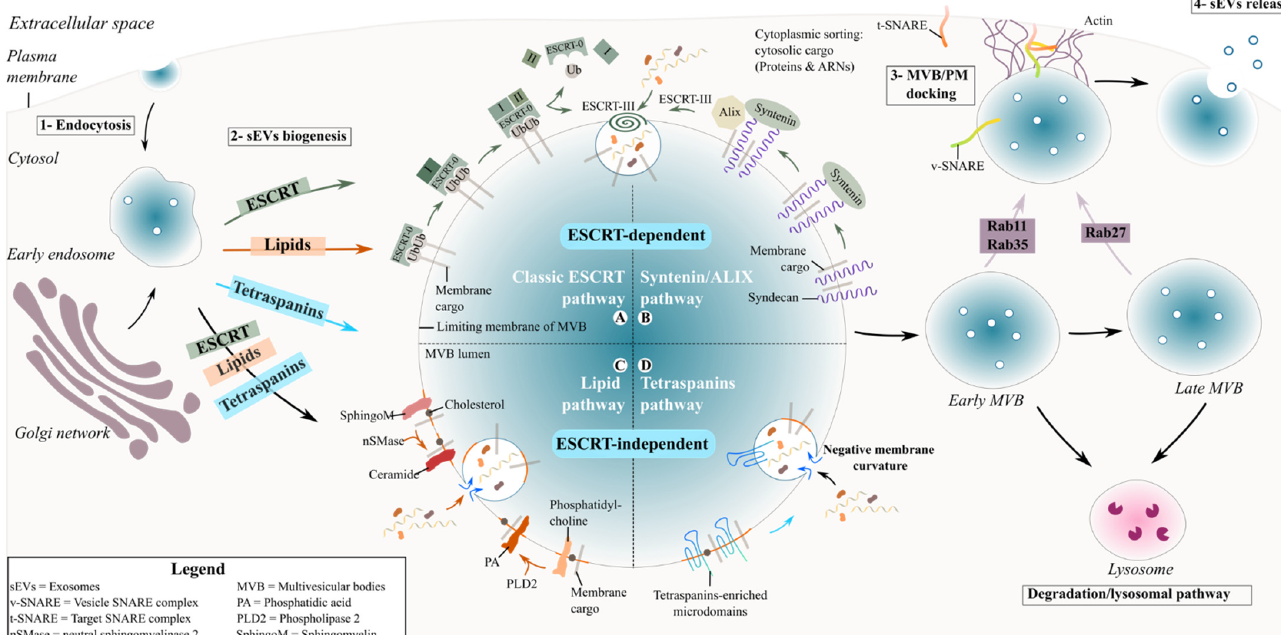
Figure 1. Biogenesis and secretion of exosomes. Schematic representation of exosome formation and release in the extracellular space. ( 1 ) Exosomes are produced as ILVs by inward budding of the endosomal membrane and accumulate in the lumen of the endosome. ( 2 ) Several mechanisms are involved in the biogenesis of exosomes such as ESCRT protein-, lipid- raft- and tetraspanin microdomain-dependent pathways. Whether one or multiple pathways are required simultaneously by one population of MVBs, or if each pathway is specific to one population of MVB, is still not clear. ESCRT-dependent pathways: ( A ) the most described mechanism involved in the biogenesis of exosomes is the ESCRT-dependent pathway requiring proteins of the ESCRT family. Specific transmembrane ubiquitinated cargo is recruited and clustered at the MVB membrane by the ESCRT-0 complex, subsequently binding to the ESCRT-I structure. The ESCRT-II complex is activated and together with ESCRT-I will create and/or stabilize the vesicle neck. Finally, ESCRT-III and its associated proteins will drive neck constriction. ( B ) The second ESCRT-dependent biogenesis pathway is the syntenin/ALIX pathway. The formation of syndecan-enriched microdomains leads to syndecan cleavage and the formation of syntenin/syndecan complexes that interact with ALIX. The syntenin–syndecan–ALIX complex then favours the recruitment of the ESCRT-III complex to support the MVB membrane curvature and abscission. ESCRT-independent pathways: ( C ) Ceramide- and phosphatidic acid-dependent pathways are based on the formation of lipid-rafts where sphingomyelin is converted to ceramide or phosphatidylcholine is converted to phosphatidic acid. The ceramide- and phosphatidic acid-enriched rafts induce the inward curvature of the MVB membrane. ( D ) Similarly, tetraspanin-enriched microdomains can induce a negative curvature in the MVB membrane. ( 3 ) MVBs will either fuse with lysosomes for degradation or with the plasma membrane, which will consequently release exosomes into the extracellular space ( 4 ). Several proteins have been identified in the transport and fusion of the MVB to the plasma membrane, such as proteins from the Rab protein family and SNARE